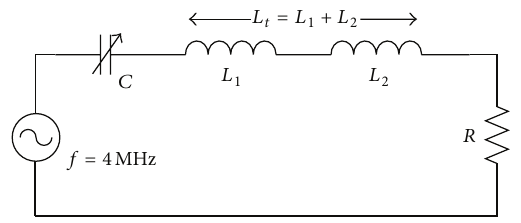
Figure 9: The RLC resonance equivalent circuits with the two inductors being connected in series. The resonance frequency is 4MHz and the two pole coils are connected in series in conditions of resonance, it will have a total inductance is 𝐿 𝑡 = 𝐿 1 + 𝐿 2 = 1918.96 𝜇 H and adjusts the value of the capacitor to be in good resonance, in which the capacitor value is 𝐶 = 0.825 pF.